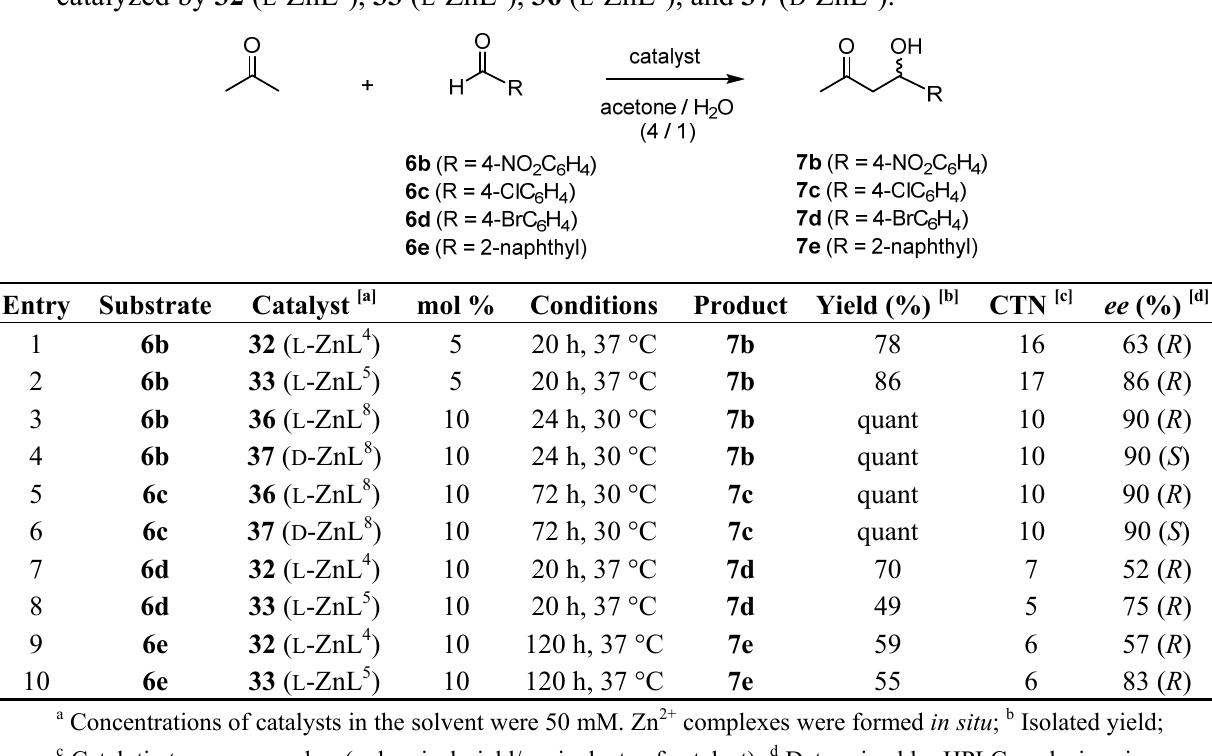
Table 2. Results for asymmetric aldol reactions between acetone and benzaldehydes ( 6b – e )